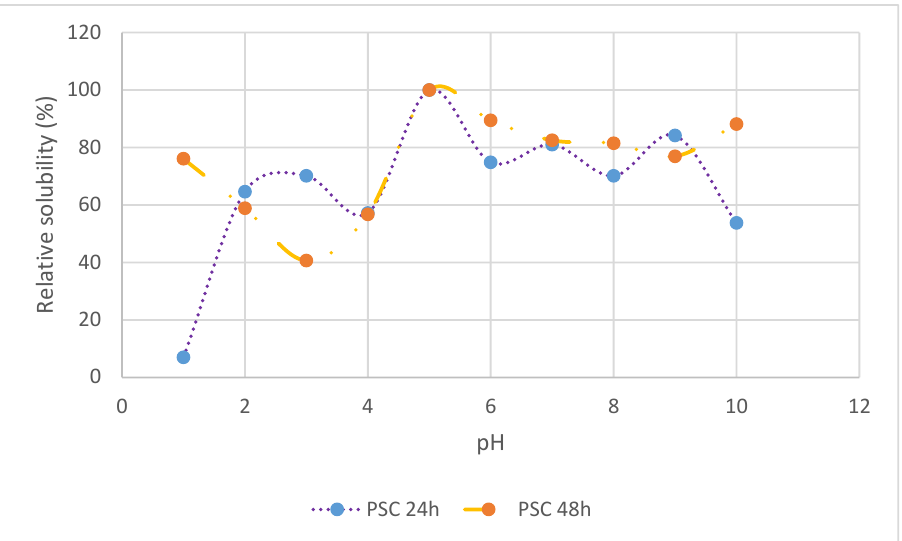
Figure 1. Solubility of PSC extracted from skin of silver catfish ( Pangasius sp.) at 24 h and 48 h extraction time in the pH range of 1 to 10.